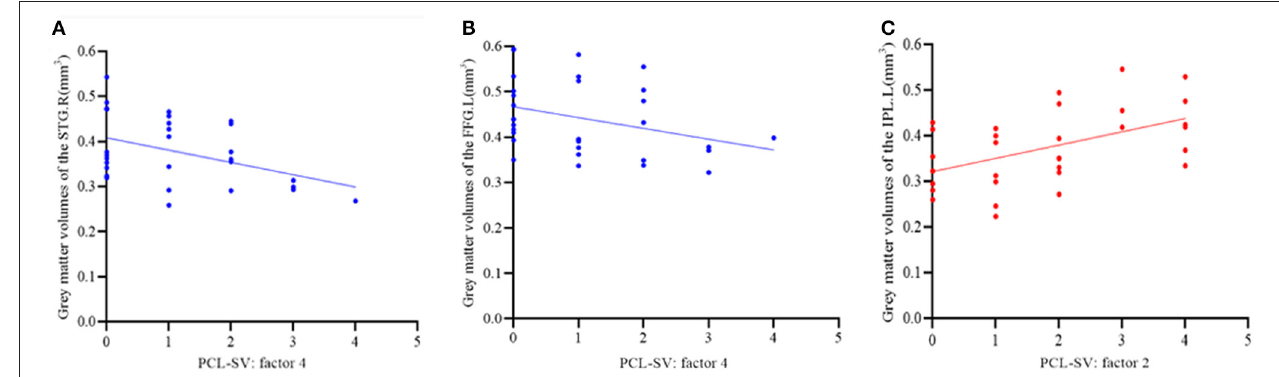
FIGURE 4 | (A,B) Spearman correlation analysis of the gray matter volumes of the right superior temporal gyrus (A) and left fusiform gyrus (B) and antisocial trait of psychopathy in the vSZ group. (C) Spearman correlation analysis of the gray matter volumes of the left IPL and unemotional trait of psychopathy in the vSZ